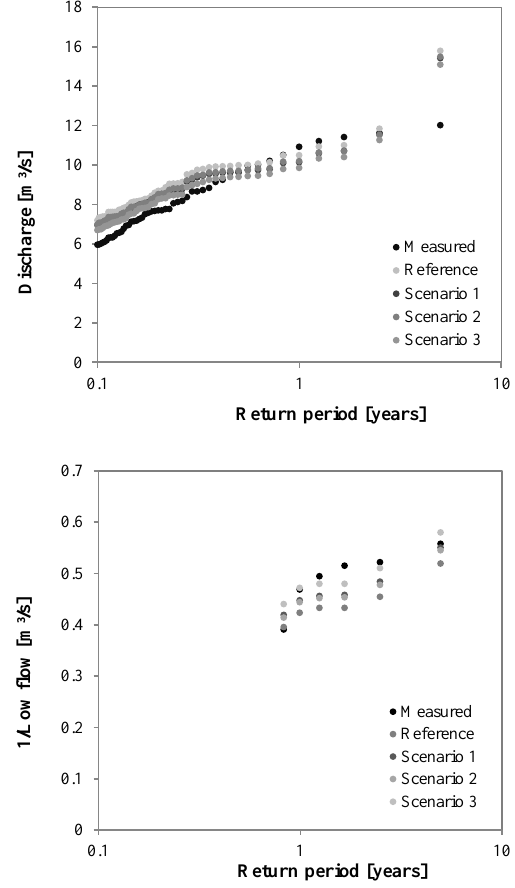
Fig. 13. (a) Return period of hourly peak flow extremes for the Grote Nete catchment between 2004 and 2008. (b) Return period of hourly low flow extremes for the Grote Nete catchment between 2004 and